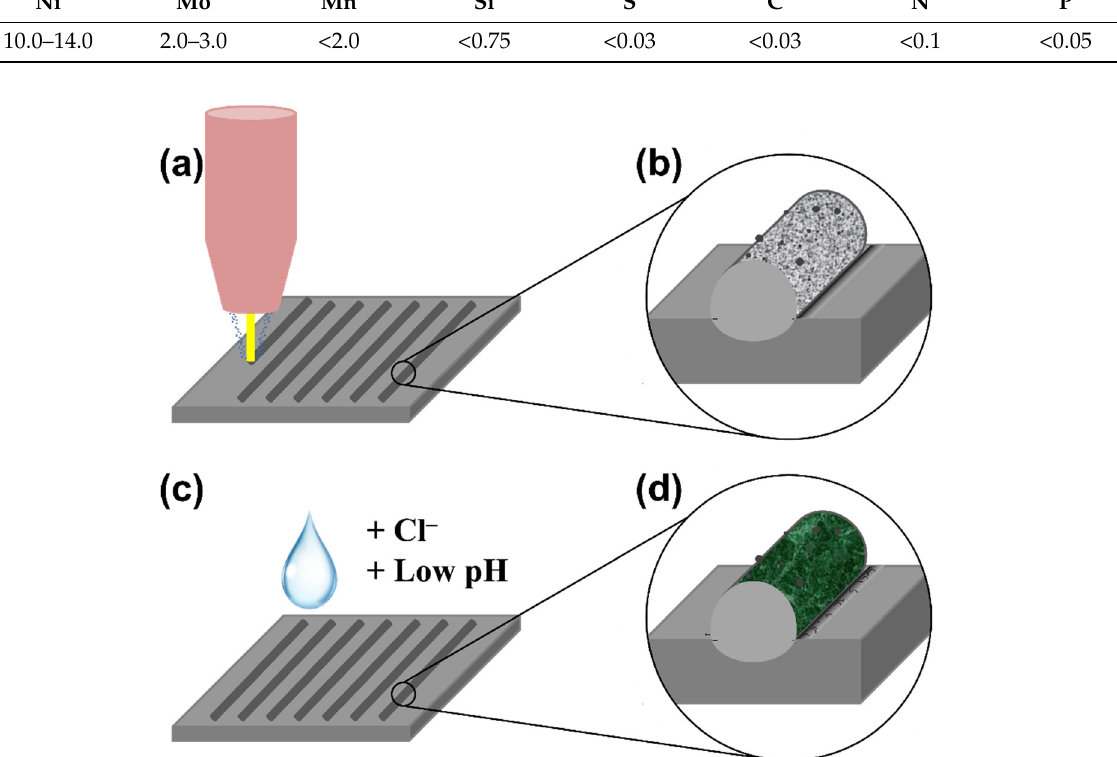
Figure 2. Schematic representing the workflow of the current study (from step a to d). ( a ) Printing of several 316L SS clads by LMD on wrought 316L base plate. ( b ) Analysis of microstructural features and defects. ( c ) Exposure of the samples to corrosive electrolyte (containing Cl – and Cl – + low pH). ( d ) Corrosion morphology analysis to determine the role of the different defects and microstructural features.